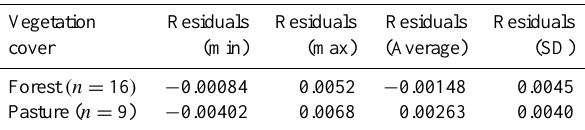
Table 3. Residuals (unstandardized) of the relationship between erodibility ( K ) and total aggregates loss ( a + b ) for forest and pas- ture vegetation